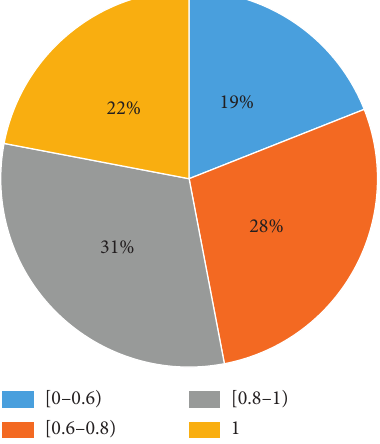
Figure 10: Proportion of coordinated development index of built environment to traffic level.